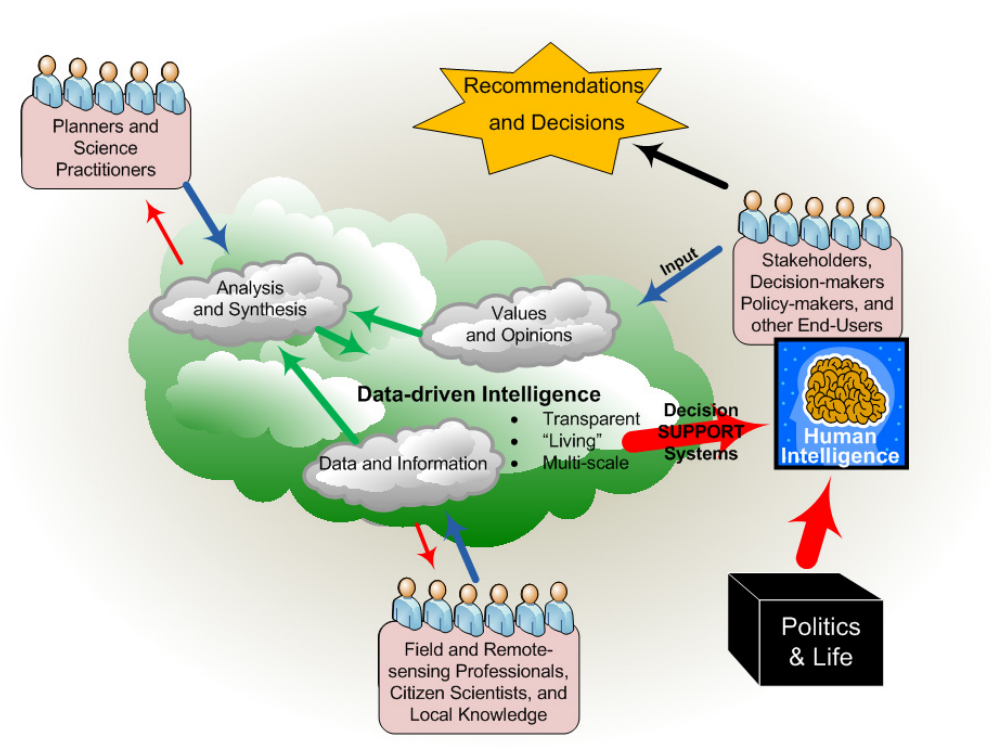
Figure 4. Knowledge flow and contributions in the Earthwise Framework. Individual people or organizations can play a role in multiple locations. Despite heavy reliance on the internet and asynchronous participation, in-person interaction is critical to strengthening relationships and should be built into the learning organizations.